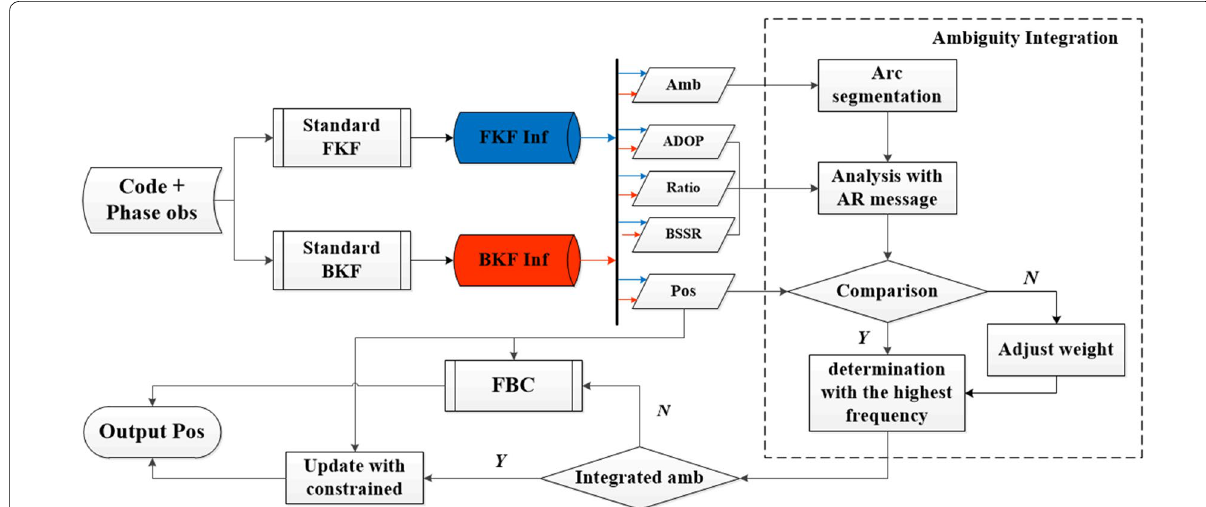
Fig. 1 Processing chain of the proposed ADBI method